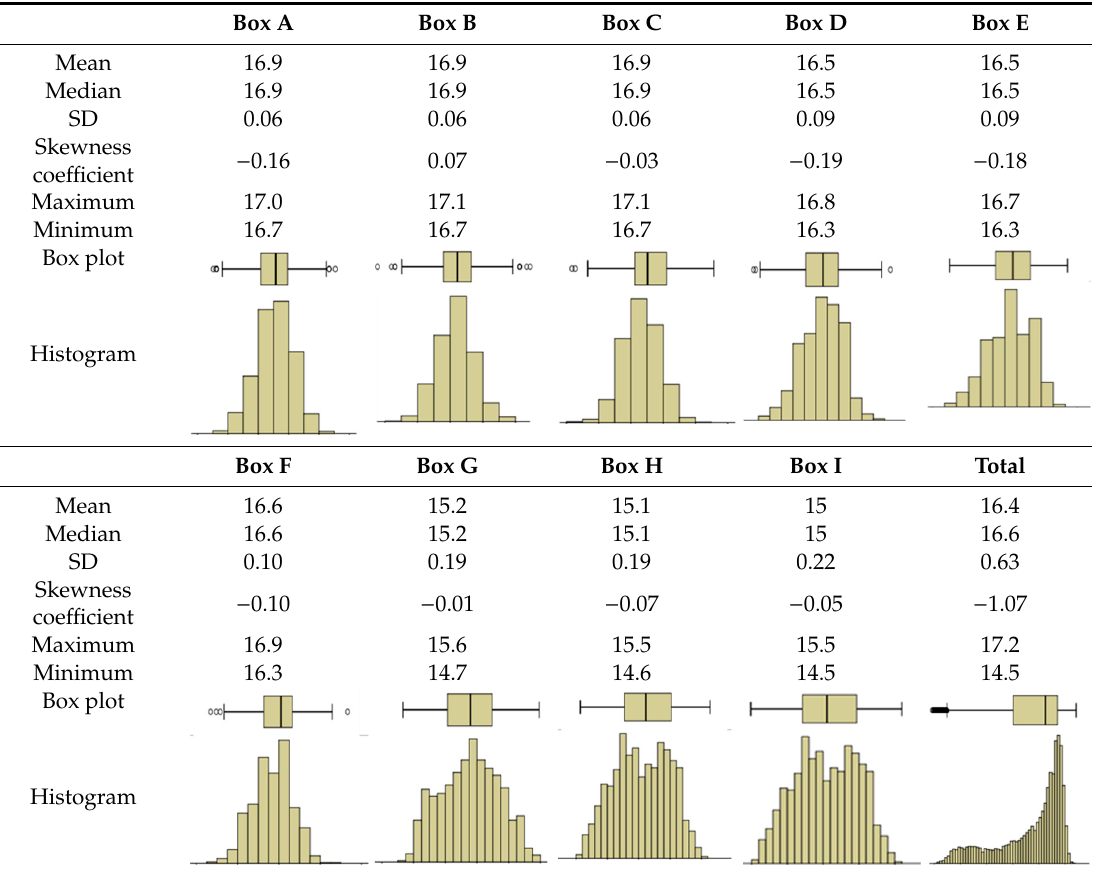
Table 3. Statistical analysis of the temperature values (°C) of the thermal image taken at the end of the humidification period.